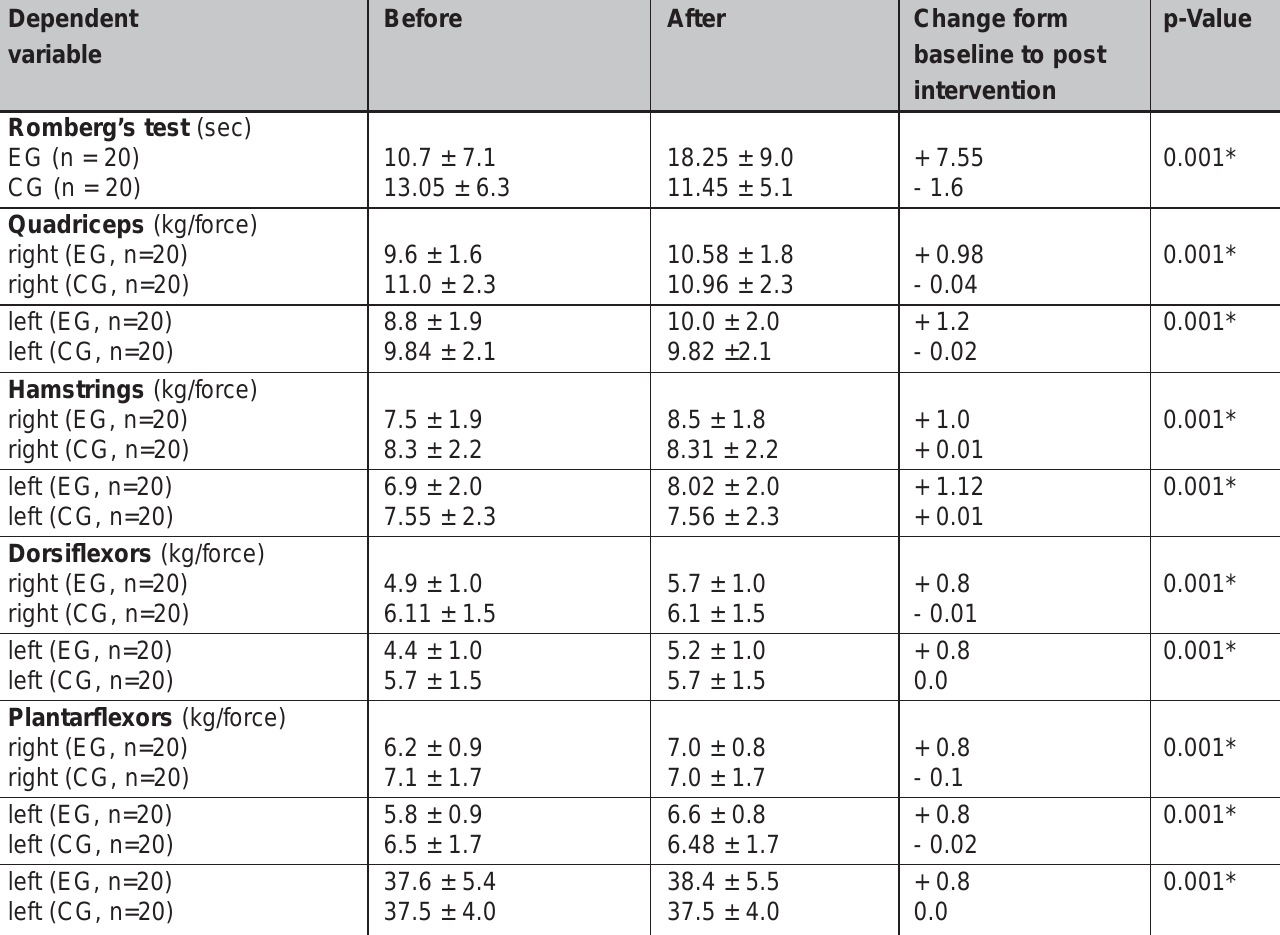
Table 2: Romberg’s test and muscle strength data pre and post intervention.